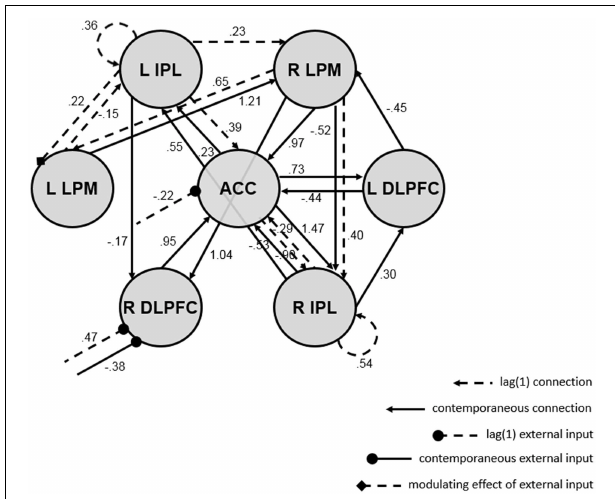
FIGURE 3 | Directed functional connectivity map from euSEM analysis of single-subject empirical data with external input (i.e., a vector indicating the experimental condition of a verbal working memory task). Dashed lines reflect first order connections, solid lines reflect contemporaneous connections, arrows reflect ROI connections, circular endpoints reflect direct effects of the task, diamond endpoints reflect modulating effects of the task, and values show connection strengths (i.e., beta-weights; all are significant at p = 0 . 05 ). The map fit the data well and had white noise residuals; see fit statistics in the text. ACC, anterior cingulate cortex; R/L DLPFC, right/left dorsolateral prefrontal cortex; R/L LPM, right/left lateral premotor cortex; R/L IPL, right/left inferior parietal